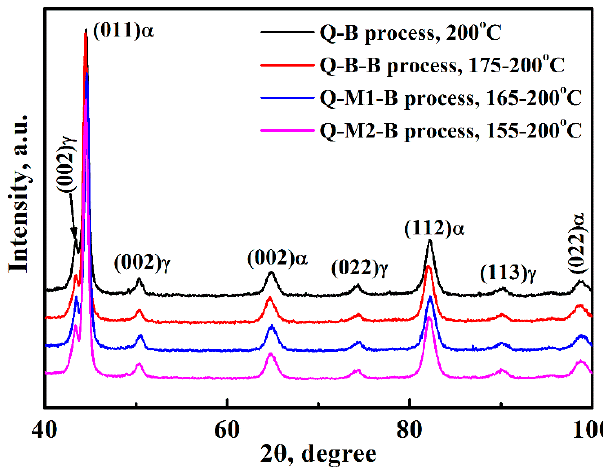
Figure 4. XRD patterns for the specimens treated by different processes.